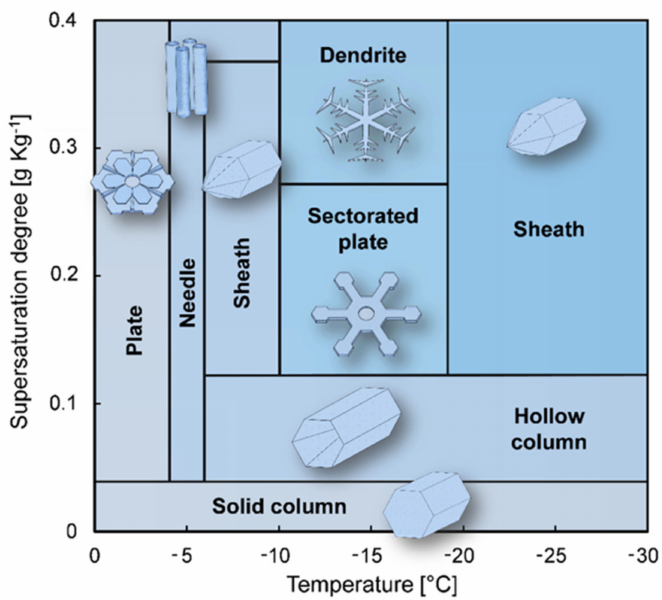
Figure 8. Kobayashi’s frost morphology